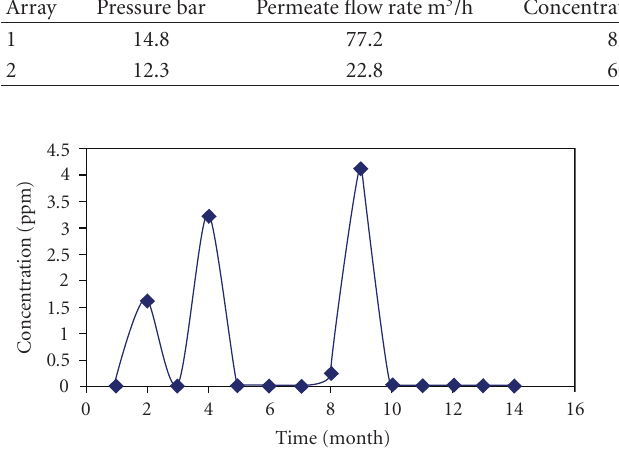
Figure 2: Ca ion concentration in the permeate. Figure 3: Mg ion concentration in the